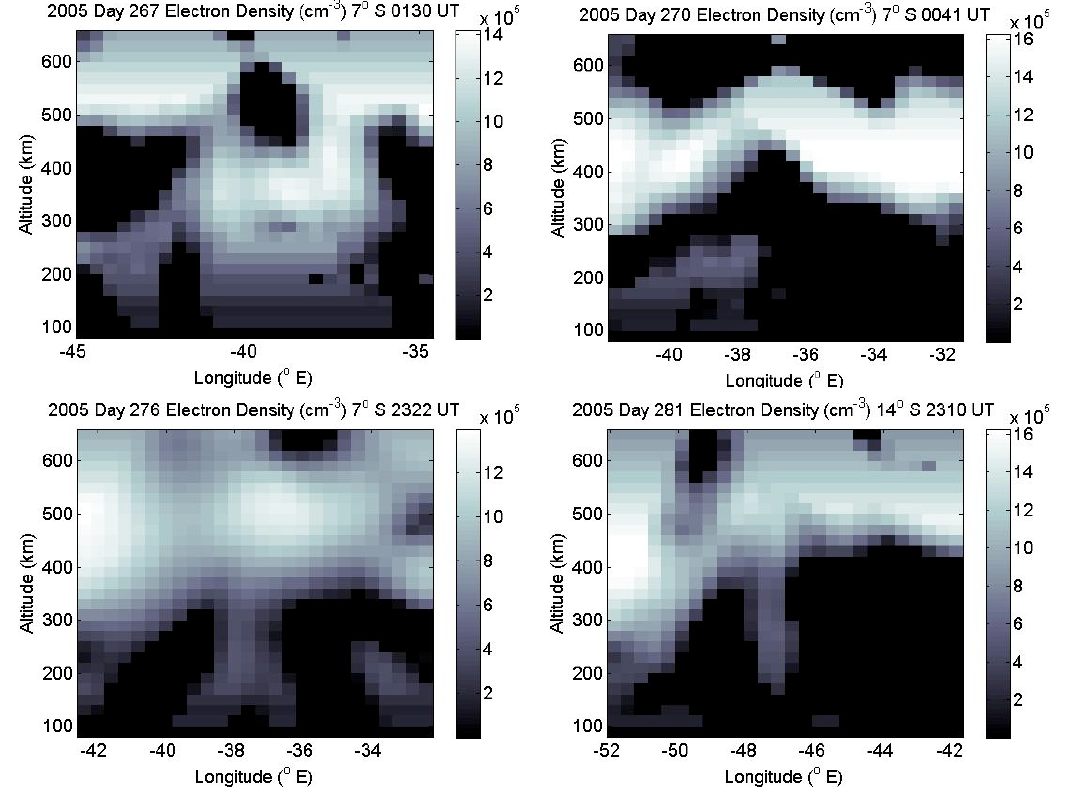
Fig. 3. Example GUVI electron density reconstructions during the Fig. 4. Example GUVI electron density reconstructions during the SpreadFEx. Fig. 4. Example GUVI electron density reconstructions during the SpreadFEx.